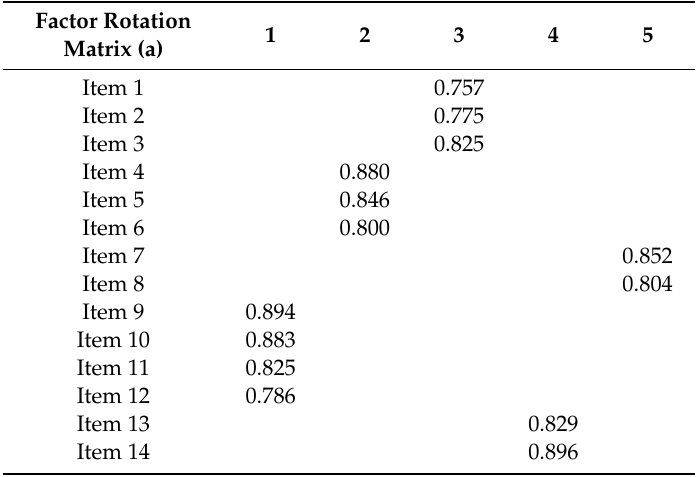
Table 2. Factor rotation matrix.